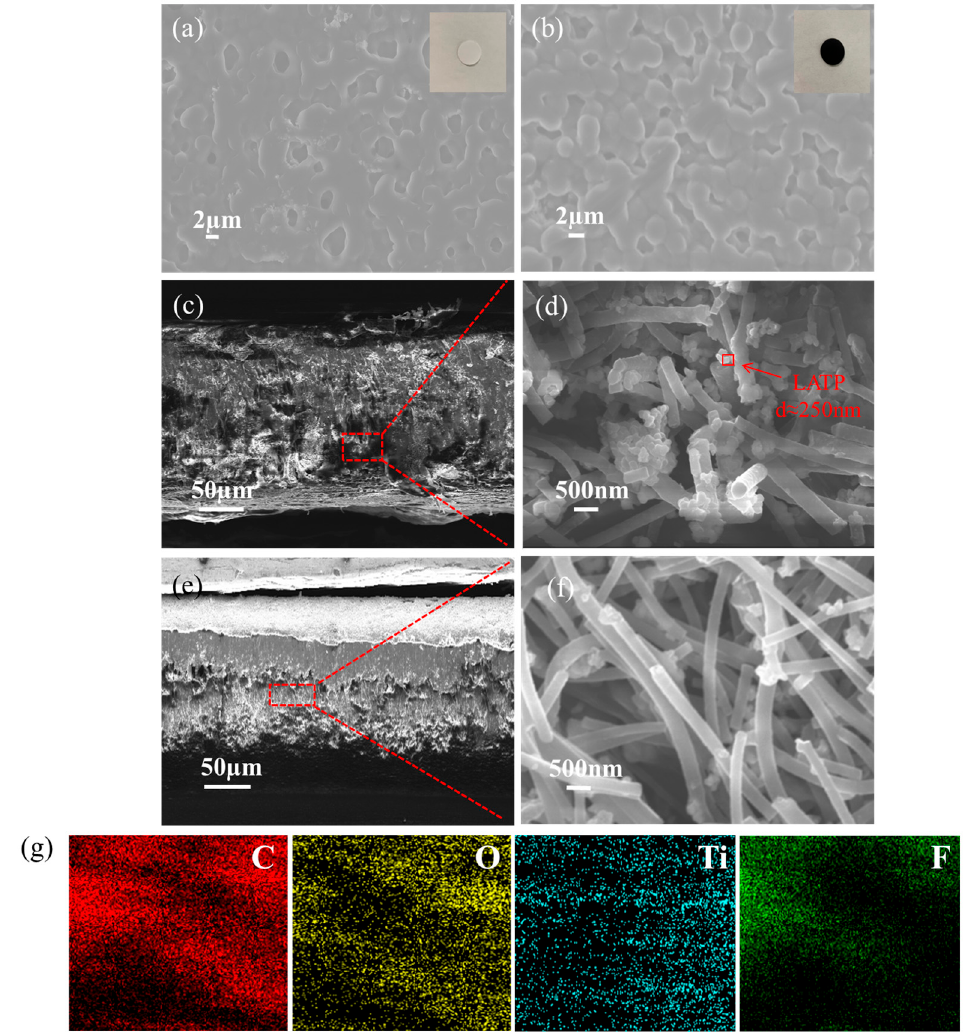
Figure 3. SEM image of PLL SSE ( a ) and PLLG SSE ( b ), cross-sectional SEM images of PLL SSE ( c , d ) and LLG SSE( e , f ) and EDS mapping images of PLLG ( g ).